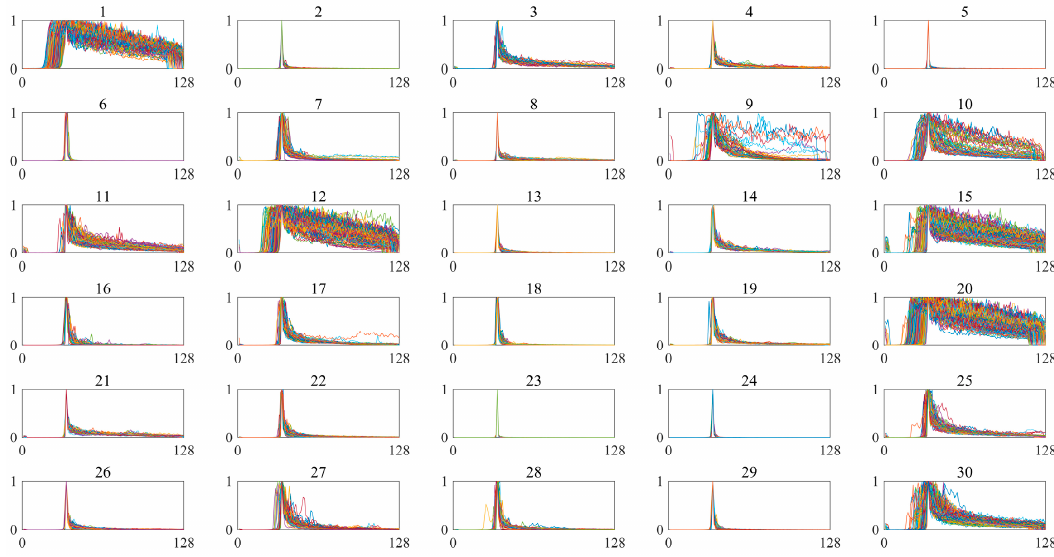
Figure 9. HY-2B altimeter waveform clusters (k = 30) after K-means clustering showing segmented waveforms.